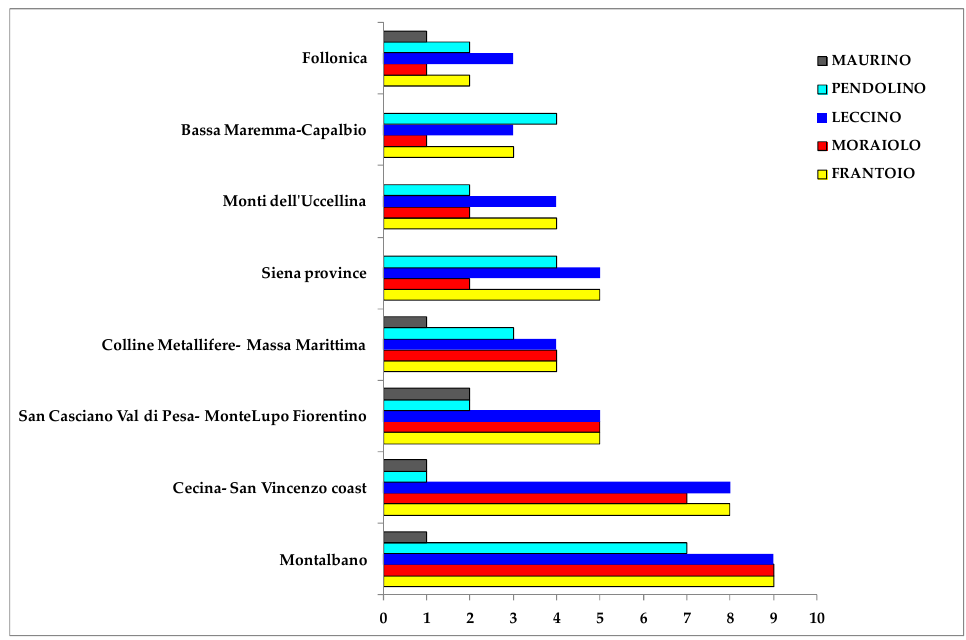
Figure 12. Bars-chart representing samples (supplied by Certified Origins Italia s.r.l .) distribution of most representative olive cultivars in the main geographical reference areas.